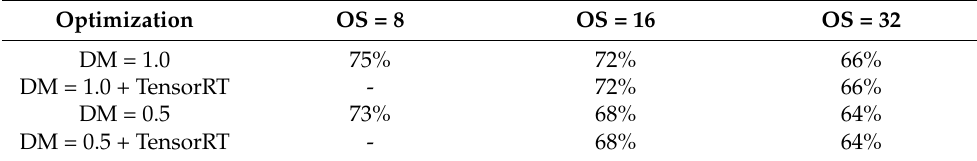
Table 8. Summary of segmentation performance with respect to different tested parameterisations.